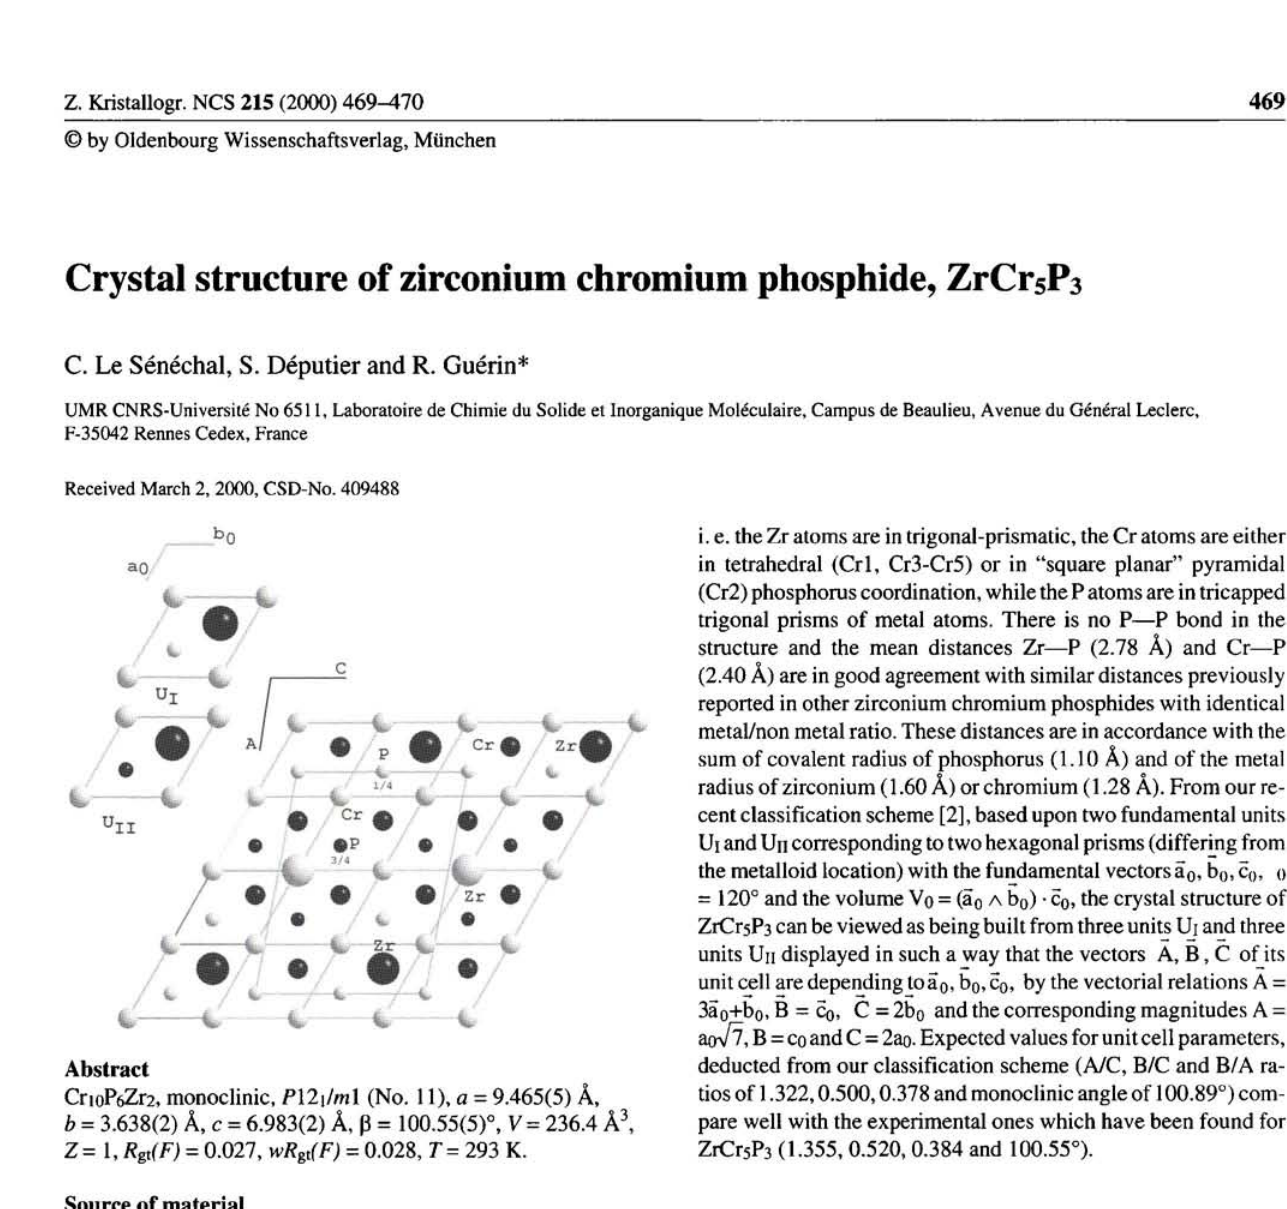
Table 1. Data collection and handling. Crystal: